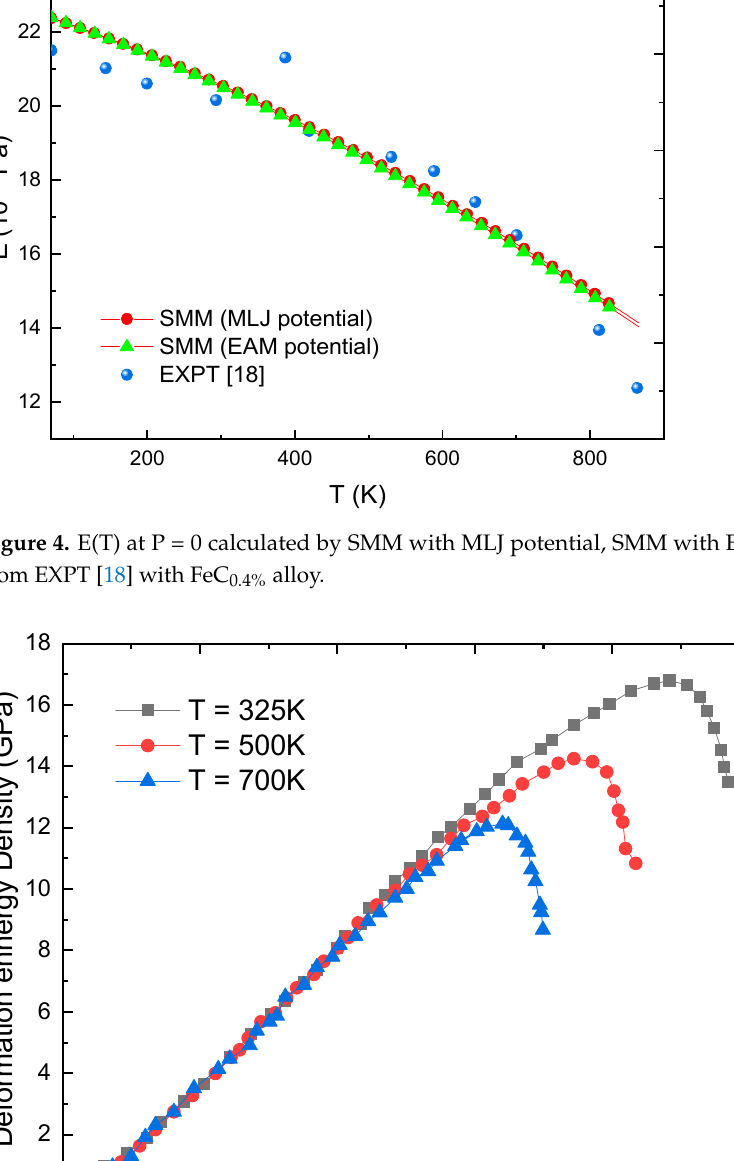
Figure 3. E(T) at P = 0 determined using the SMM with MLJ potential, SMM with EAM potential [47] and from EXPT [18] with FeC 0.2% alloy.